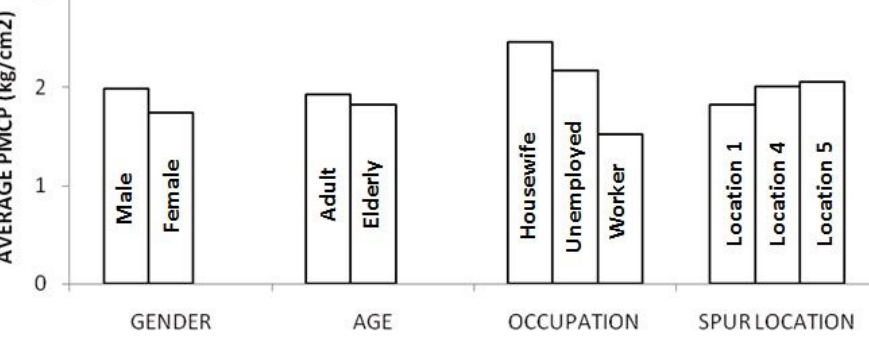
Figure 6. The correlation between the classification of gender, age, occupation, and spur location to the average pain minimum compressive pressure (PMCP).